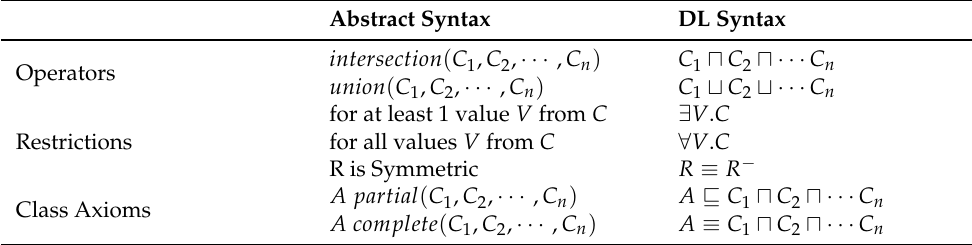
Table 1. Basic OWL-DL semantic syntax used to formally define the proposed ontology.